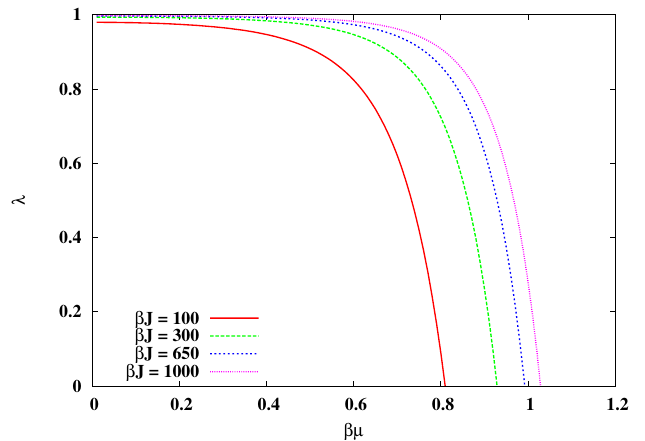
Figure 4 . The Lyapunov exponent (cid:21) is again normalised and takes values between 0 and 1. This (cid:12)gure shows dependence of (cid:21) on (cid:12)(cid:22) for di(cid:11)erent values of (cid:12)J .